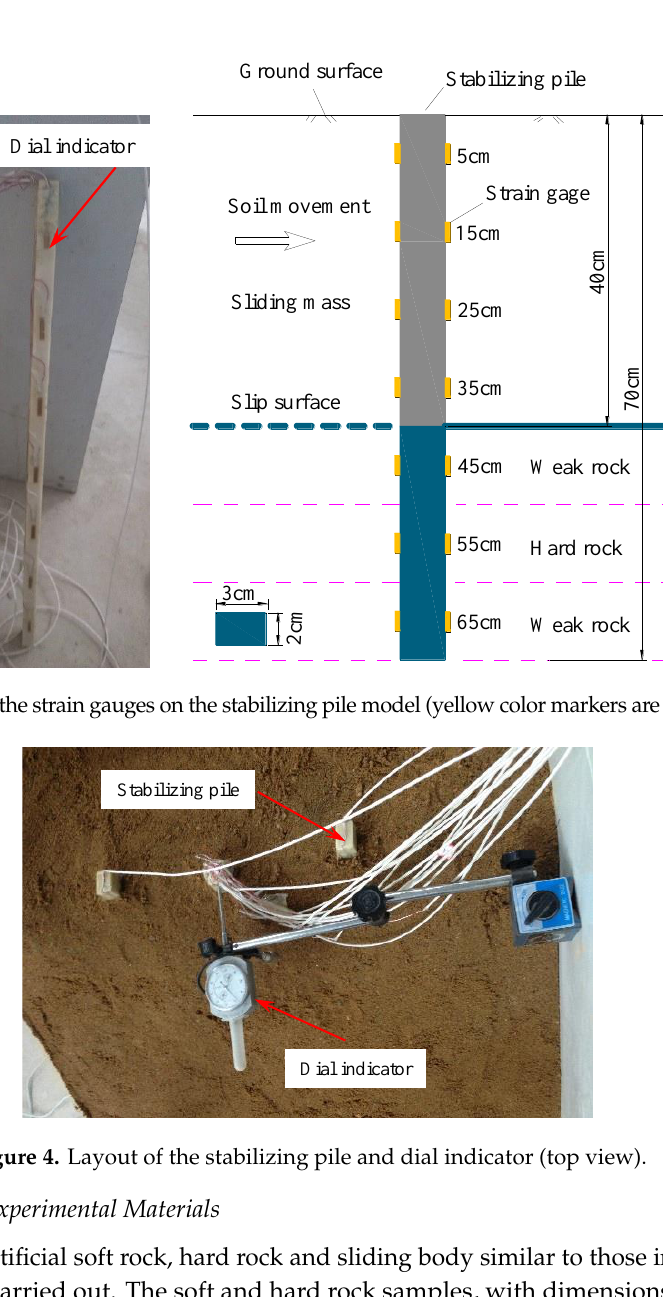
Figure 4. Layout of the stabilizing pile and dial indicator (top view).